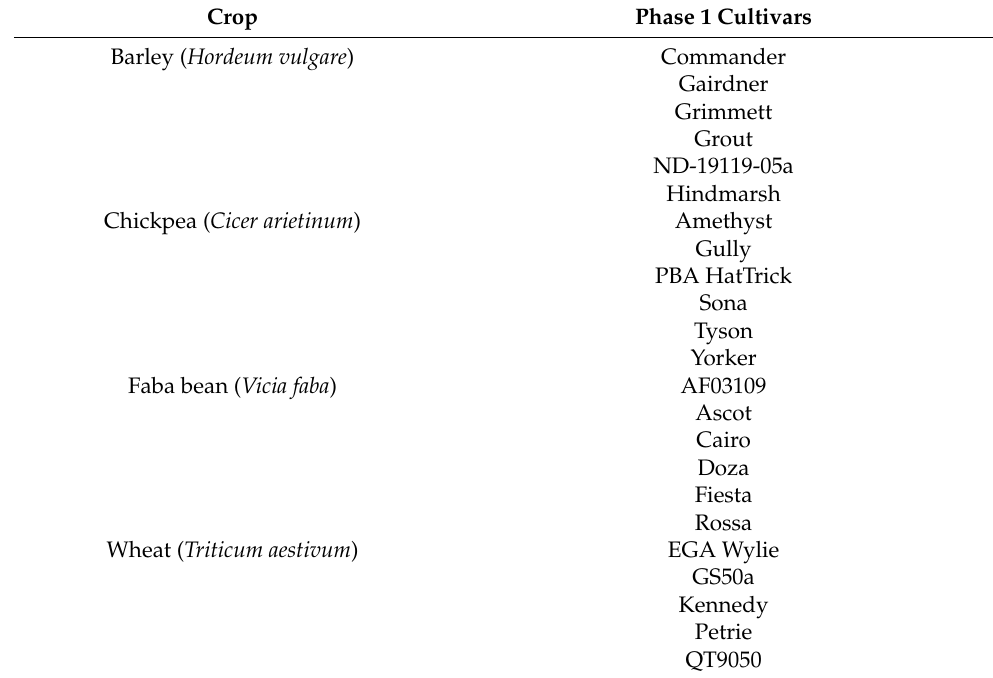
Table 2. Crop cultivars sown in Phase 1 of the experiments at Formartin, Queensland, Australia. Crop